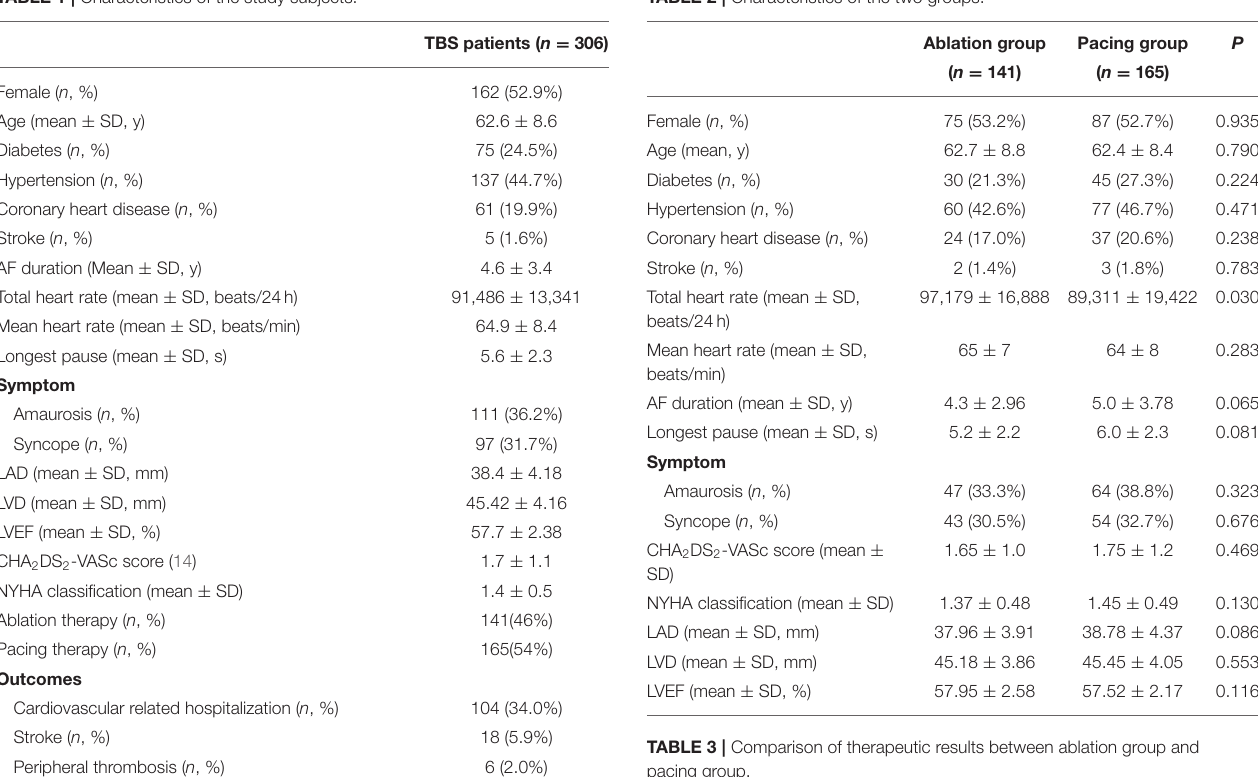
TABLE 1 | Characteristics of the study subjects. TABLE 2 | Characteristics of the two groups.